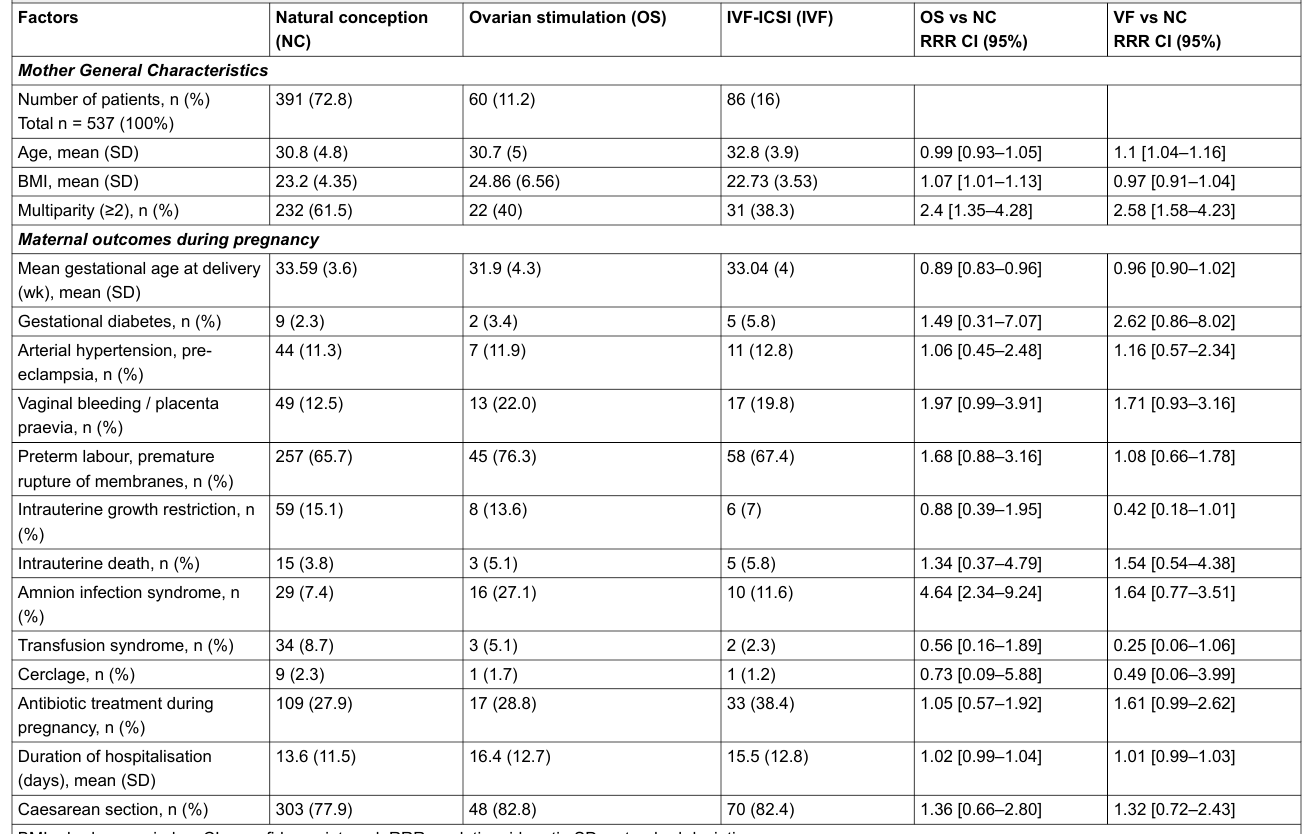
Table 1 : Characteristics of the mothers and maternal outcome according to the different modes of conception. Factors Mother General